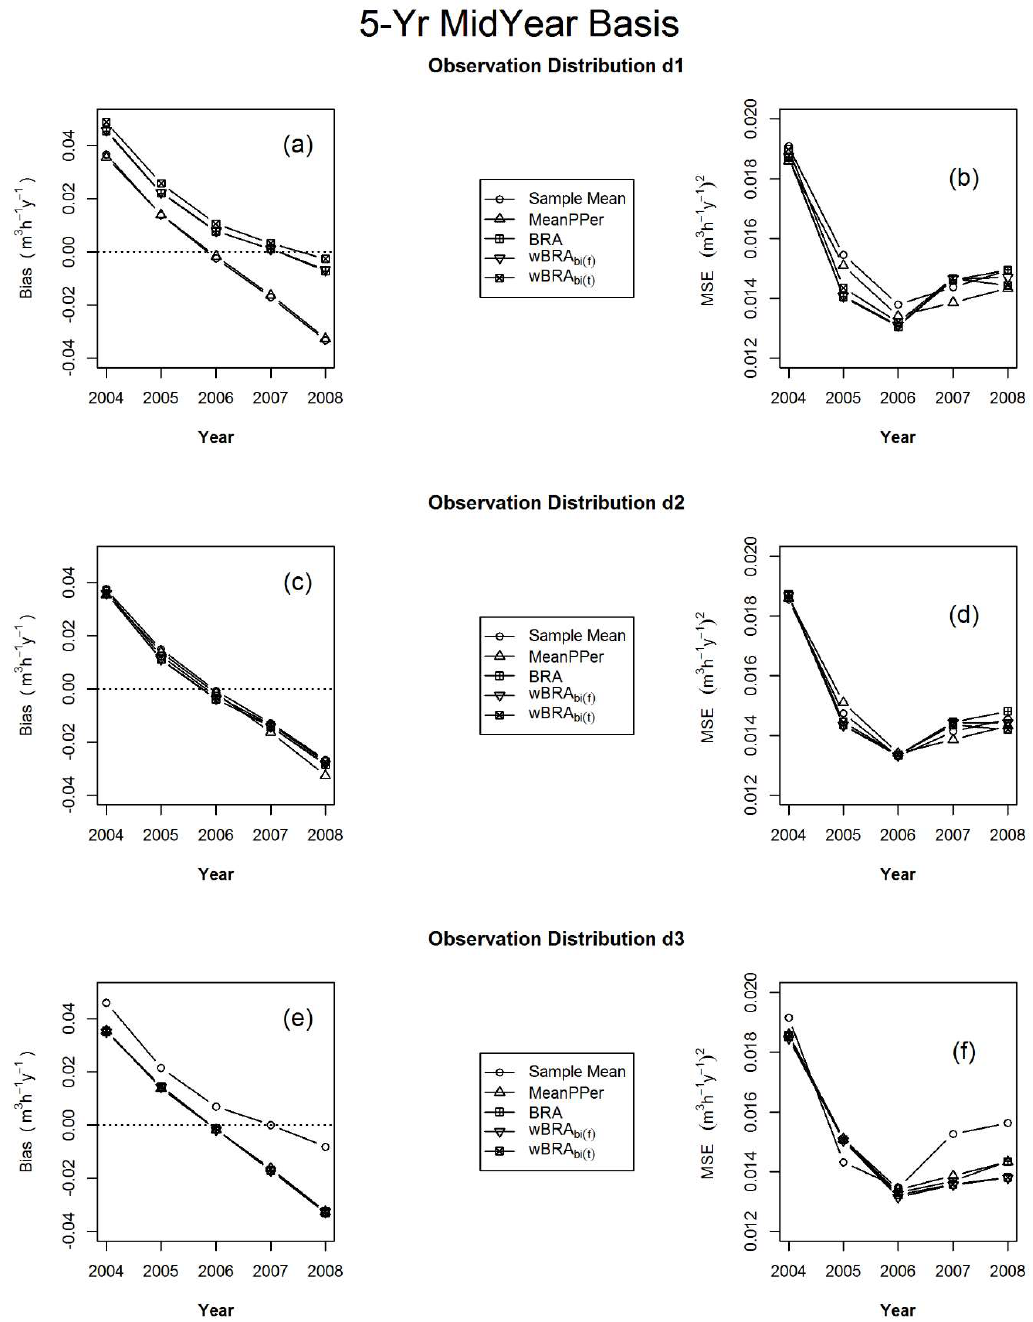
Figure 7. The simulation mean bias in the left graphs ( a , c , and e ) and the simulation mean of mean-squared errors in the right graphs ( b , d , and f ) for Estimand 2 (with a five-year mid-year basis), for each distribution d1 through d3, from top to bottom, respectively. These summary statistics were compiled after 100 iterations of composite samples of size 1000, for each of five sample observation lengths, within each of the 125 populations.